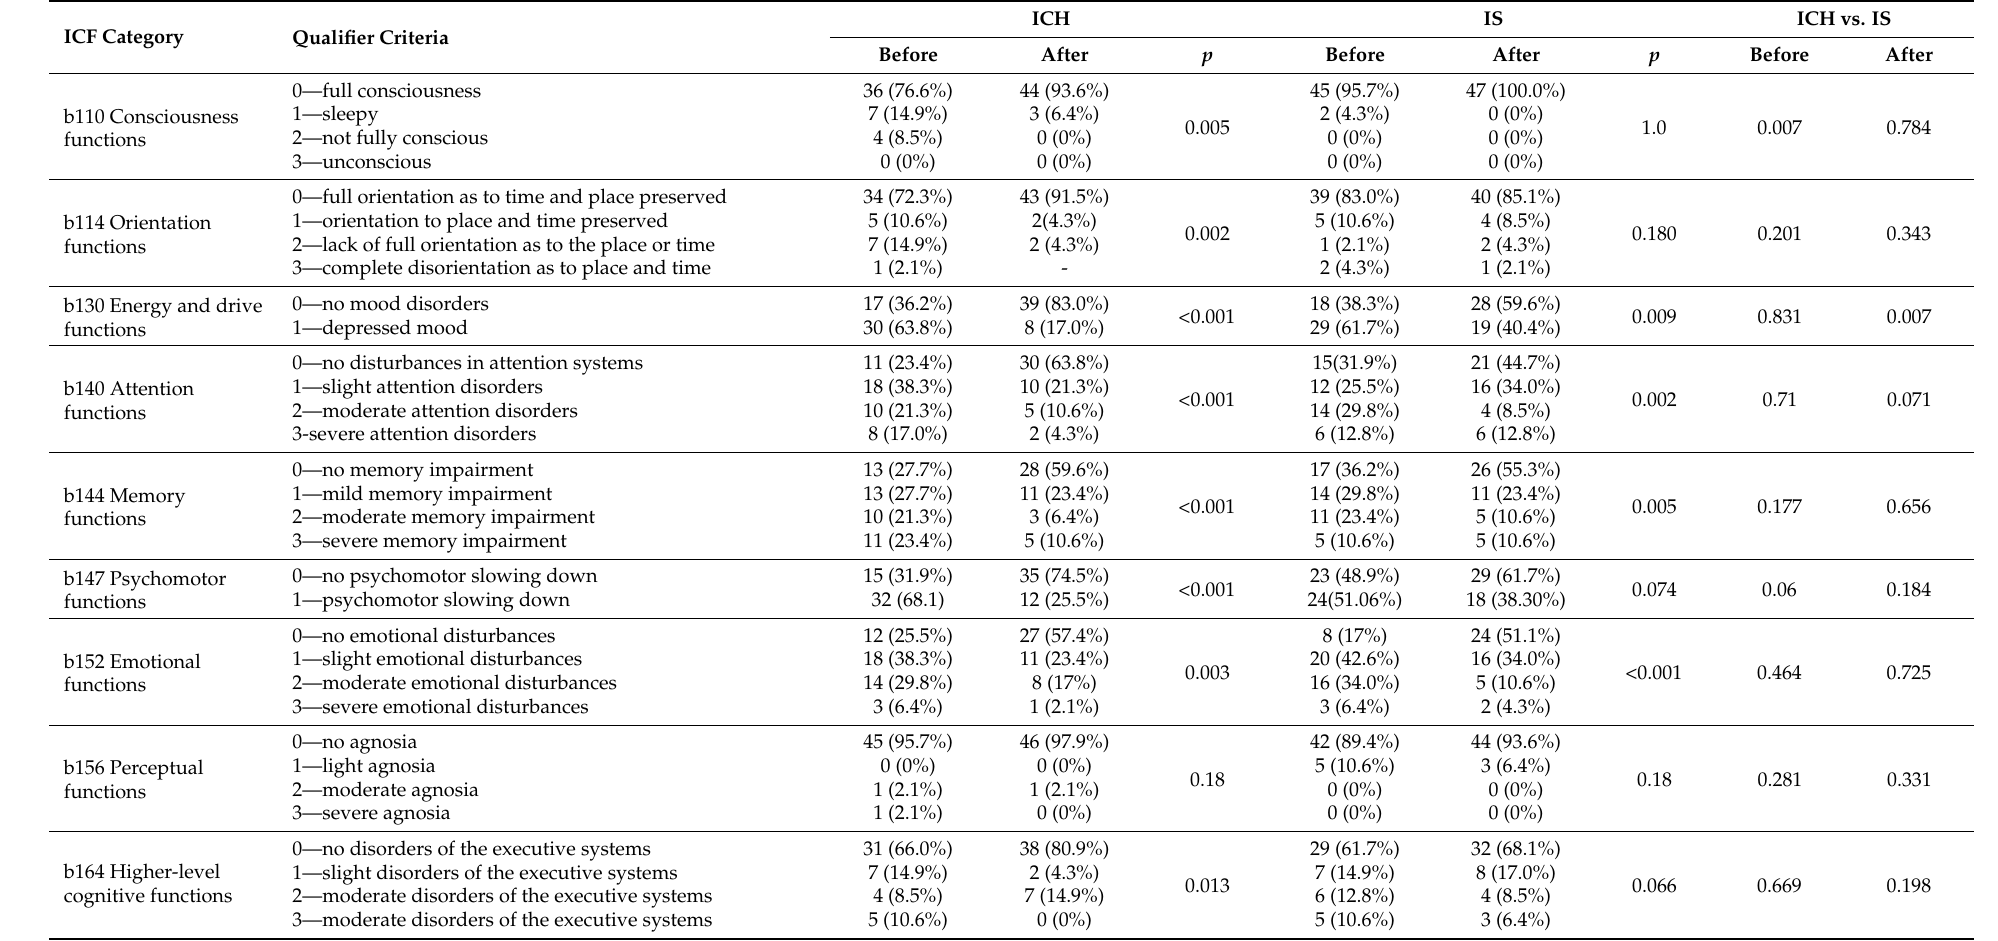
Table 2. Consciousness and cognitive-behavioral disorders in patients after ICH and IS before and after